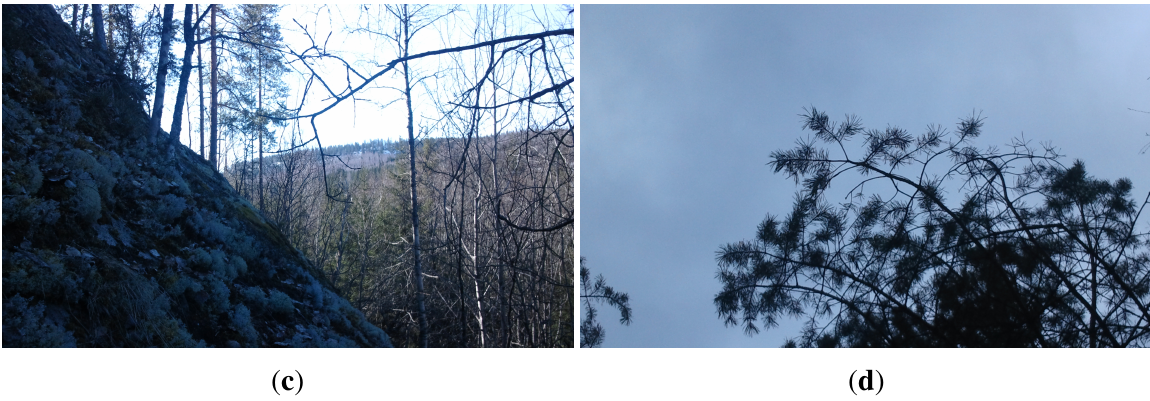
Figure 9. Examples of plots with anomalies: ( a ) Plot 3 east facing; ( b ) Plot 5 east facing; ( c ) Plot 17 south facing; ( d ) Plot 6 sky facing. The low number of trees in these plots or the lack of thereof led to very few LiDAR points in those